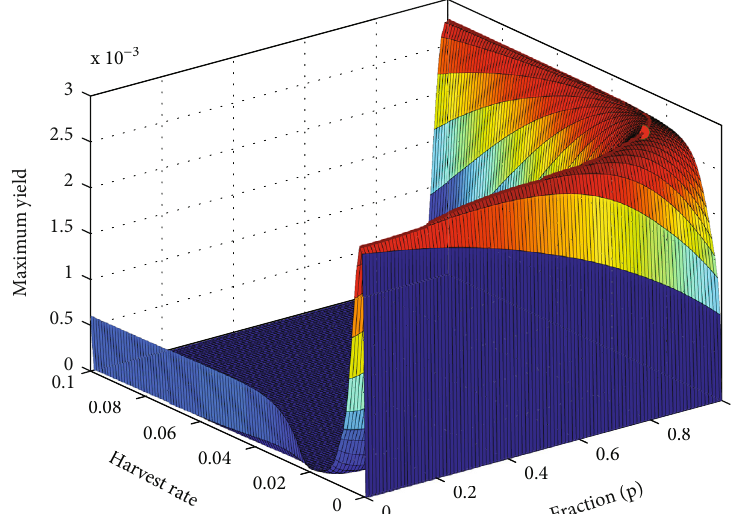
Figure 6: Simulation results, using system (18), including both African cat fi sh and Nile tilapia with proportional harvesting rates, i.e., ! = ðð 1 − p Þ h , ð 1 − p Þ h , ph , ph , ð 1 − p Þ h , ph Þ where 0 ≤ p ≤ 1 . The initial values are chosen positive, and other parameter values can be h p found in Tables 3 – 5.